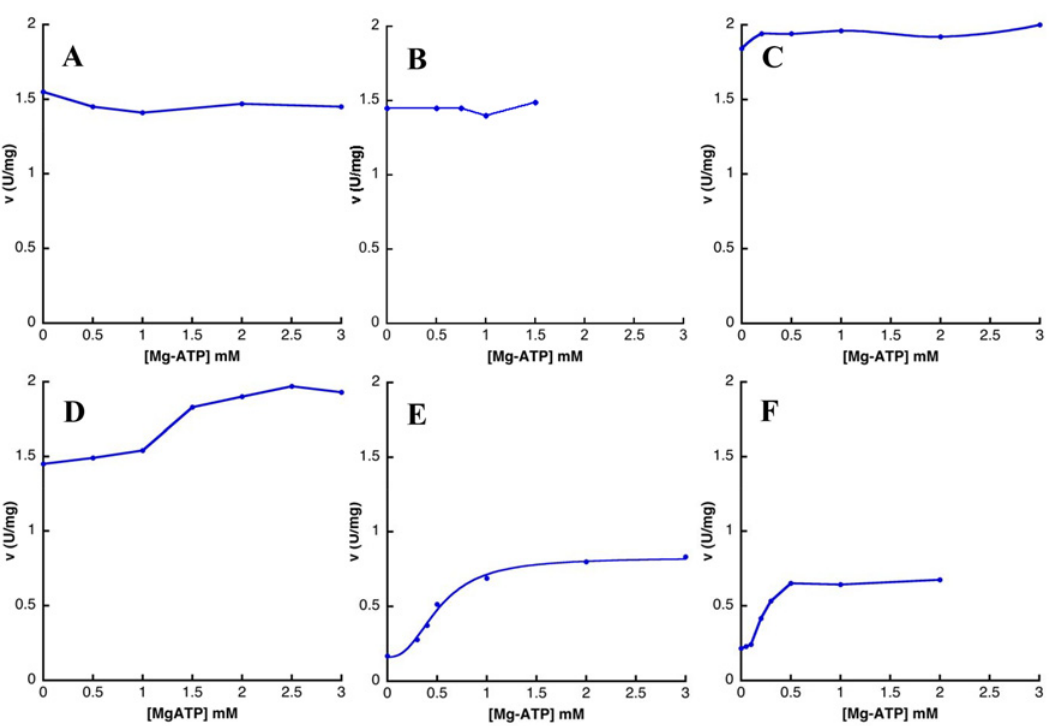
Fig 5. IMPDHbt (A), IMPDHba (B), IMPDHkp (C), IMPDHsa (D), IMPDHlpp (E) and IMPDHnm (F) activity versus MgATP concentration. Reaction rates were determined at constant IMP and NAD concentrations (respectively, 0.05 mM and 0.3 mM for IMPDHbt, 0.5 mM and 2 mM for IMPDHba, 0.05 mM and 0.8 mM for IMPDHkp, 0.3 mM and 1.5 mM for IMPDHsa, 0.5 mM and 0.5 mM for IMPDHlpp and